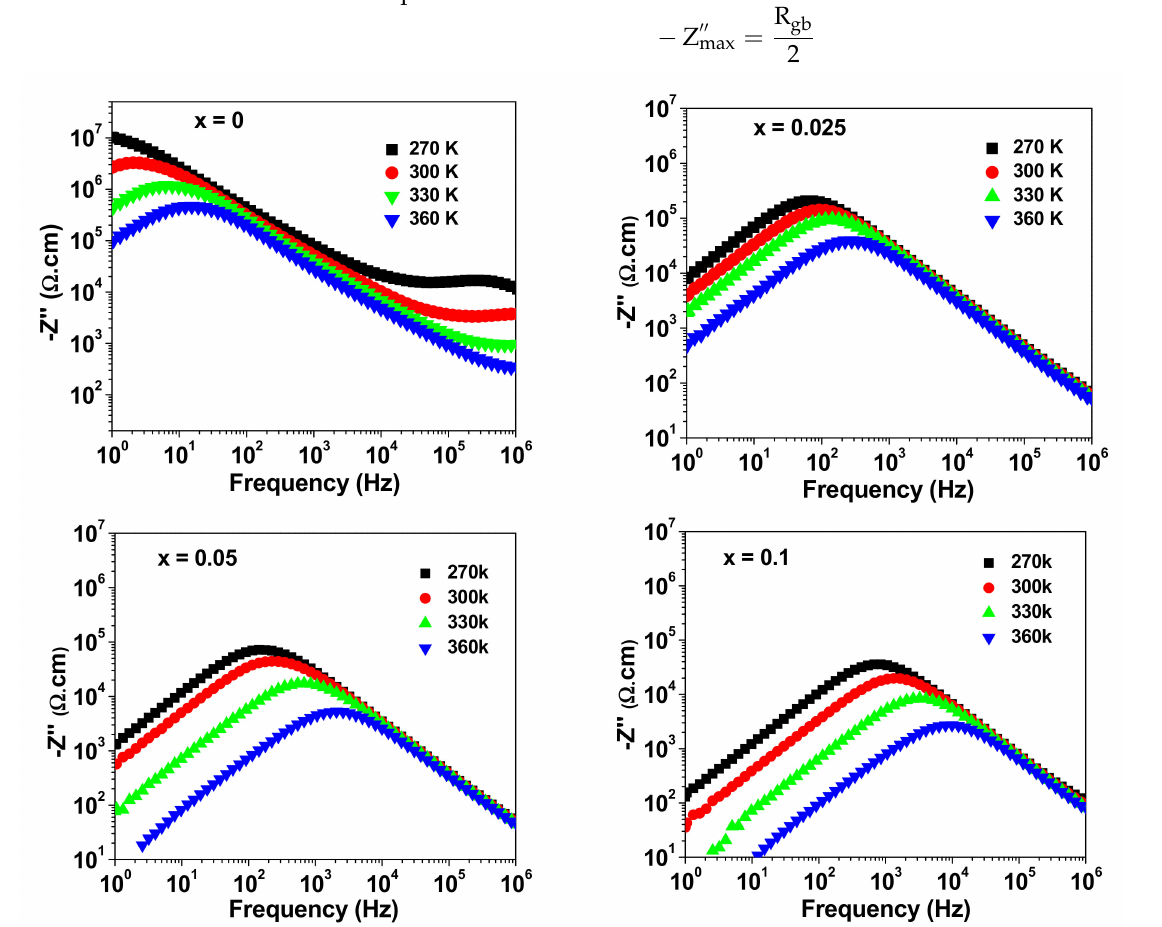
Figure 6. Frequency dependence of − Z” at different temperatures for NSTO